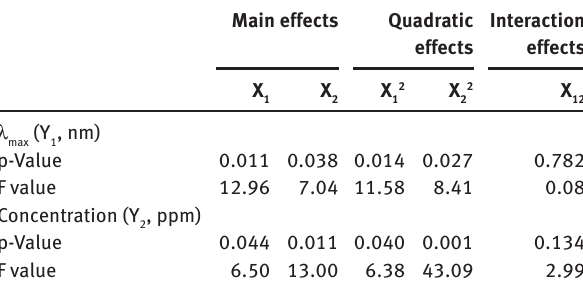
Table 3: Significance probability (p-value, F ratio) of regression coefficients in the second-order polynomial